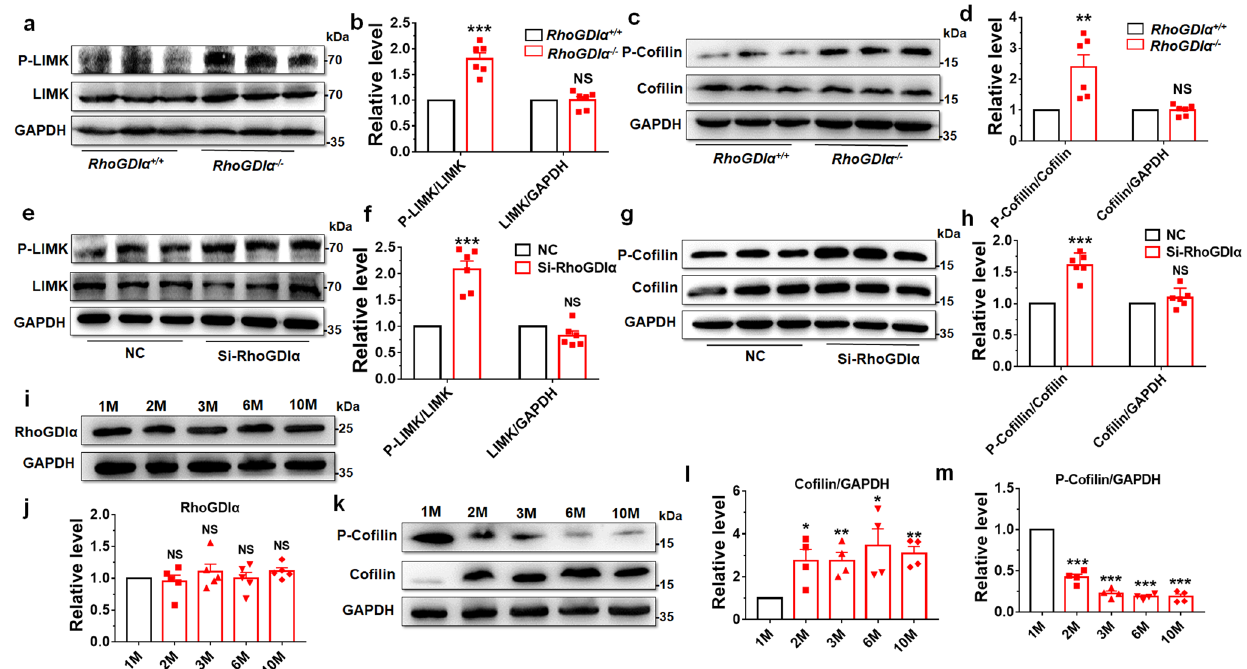
Fig. 4 LIMK/co fi lin signaling pathway was activated after knockout or knockdown of RhoGDI α . a – d The levels of P-LIMK, LIMK, P-co fi lin, and co fi lin were compared between RhoGDI α + / + and RhoGDI α − / − in mouse testes. n = 6 biologically independent animals. e , f GC-1spg cells were treated with Si- RhoGDI α for 48 h, and the protein was extracted to detect LIMK and its phosphorylation level. g , h Levels of P-co fi lin and co fi lin in GC-1spg cells were also tested after Si-RhoGDI α treatment. f , h n = 6 batches of cells in each group. i , j Protein level of RhoGDI α was detected by Western blot in WT mice at 1 month (1 M), 2 months (2 M), 3 months (3 M), 6 months (6 M), and 10 months (10 M) of age. n = 5 biologically independent animals. k – m Protein expression and phosphorylation of co fi lin in WT mice of different ages. n = 4 biologically independent animals. * P < 0.05, ** P < 0.01, *** P < 0.001 vs RhoGDI α + / + or NC groups. NS non-signi fi cant vs RhoGDI α + / + or NC groups. Data are presented as the mean ± standard